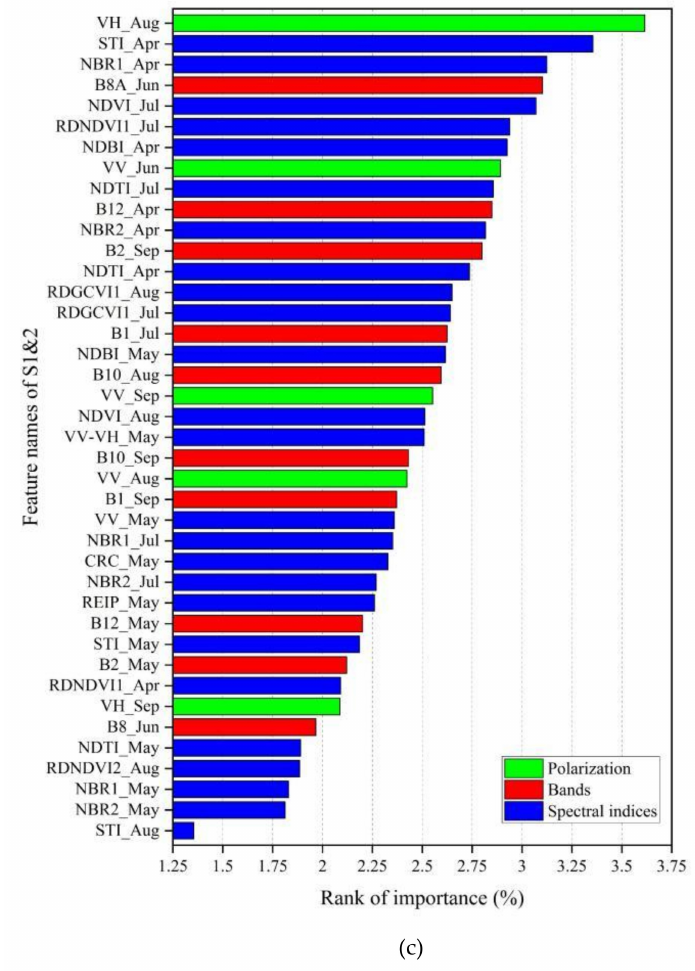
Figure 5. The feature indicators that used to construct three different RF maize extraction models of RF_S1, RF_S2, and RF_ S1&S2, respectively. ( a ) the 24 feature indicators from S1 (alone); ( b ) the 30 optimal feature indicators from S2 (alone); ( c ) the optimal 40 feature indicators from combined S1 and S2